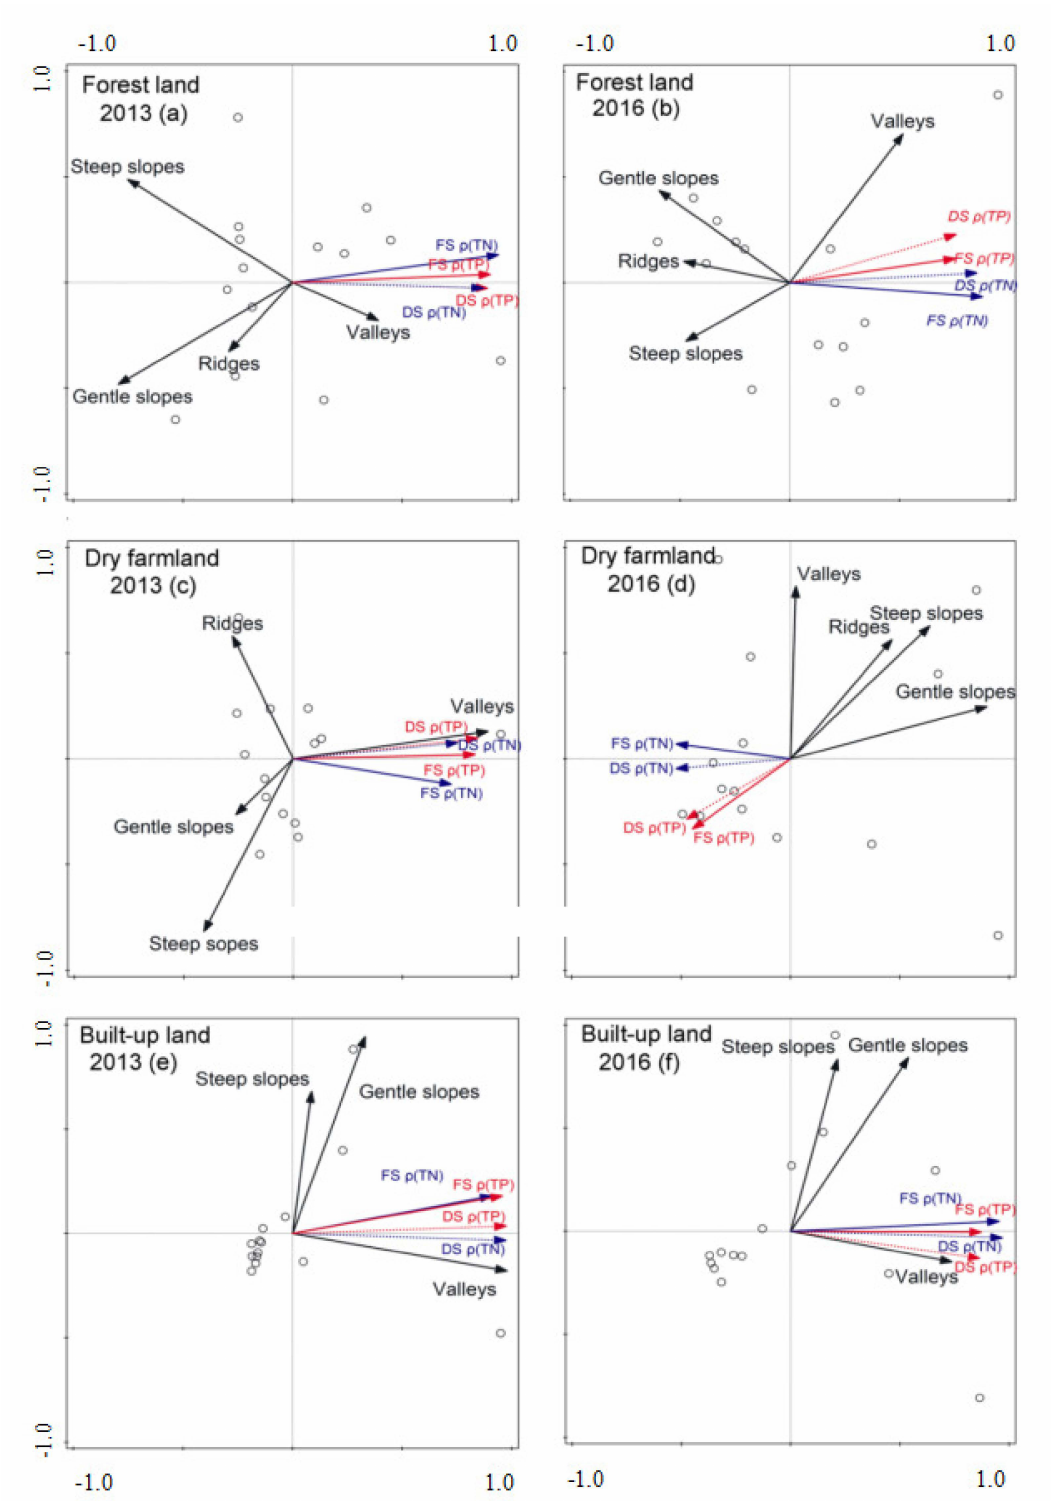
Figure 19. Redundancy analysis of land use composition and TP and TN concentrations in different TPI: Forest land in 2013 ( a ) and 2016 ( b ); Dry farmland in 2013 ( c ) and 2016 ( d ); Built-up land in 2013 ( e ) and 2016 ( f